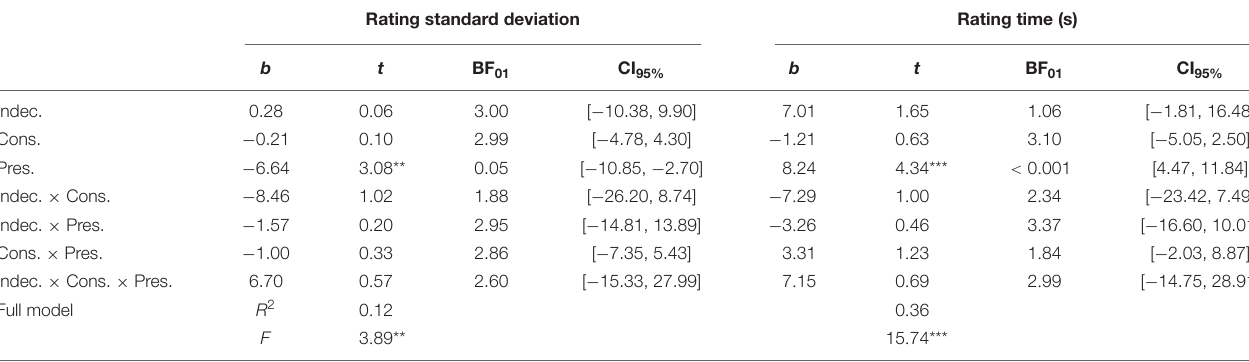
TABLE 1 | Regression of evaluation difficulty (rating standard deviation and rating time) on indecisiveness, consequence of ratings, presentation, and their interactions in Study 2a. Rating standard